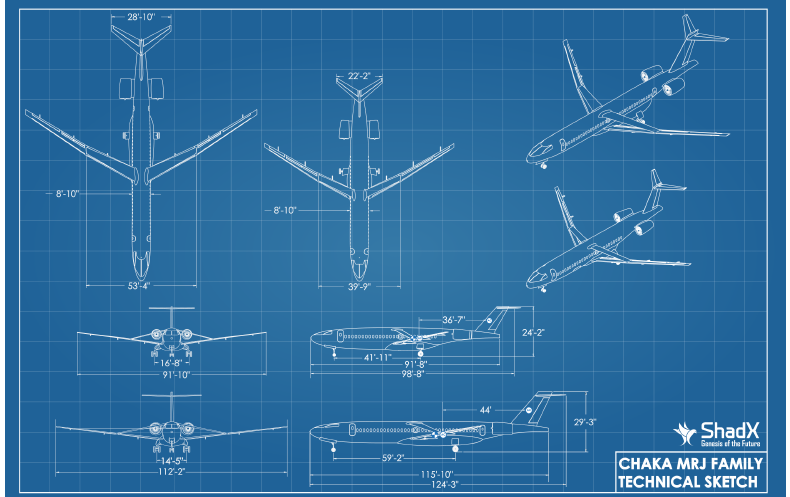
Figure 1. Chaka Modern Regional Jet (MRJ) Family [4].